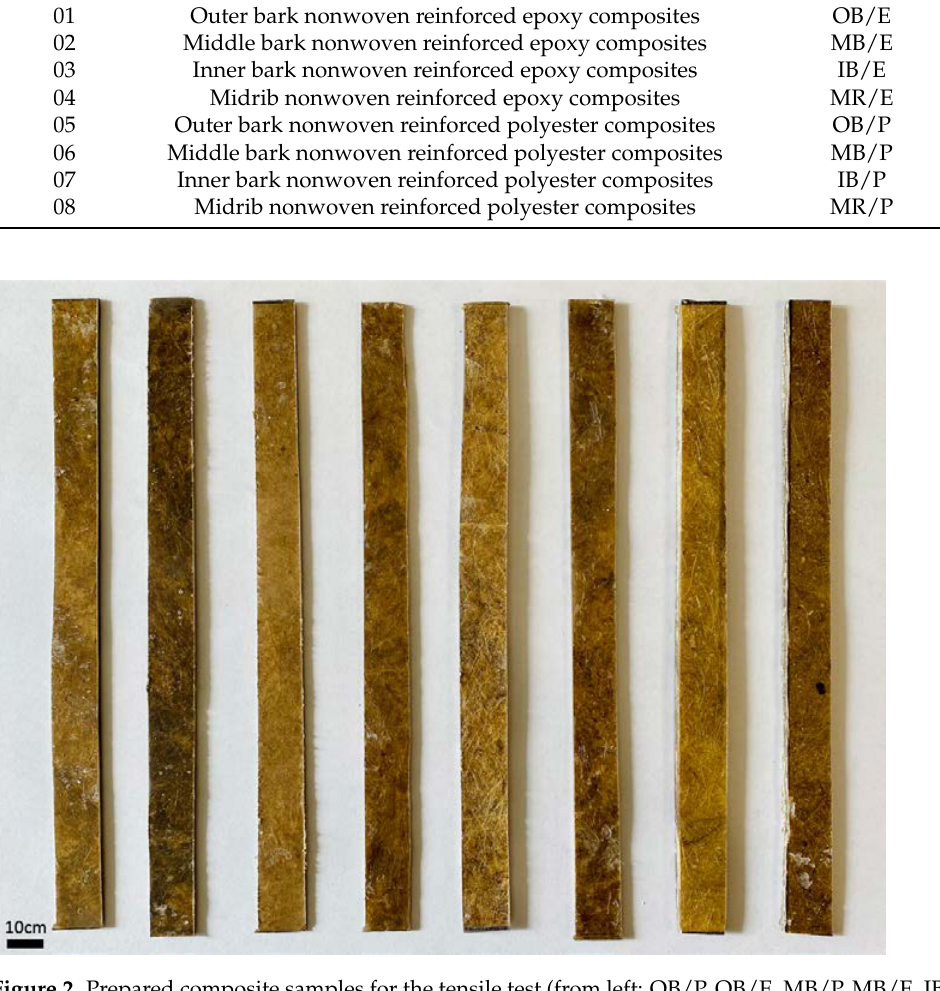
Figure 2. Prepared composite samples for the tensile test (from left: OB/P, OB/E, MB/P, MB/E, IB/P, IB/E, MR/P,